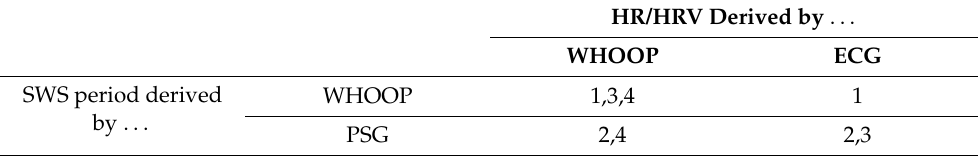
HR/HRV Derived by . . . WHOOP ECG